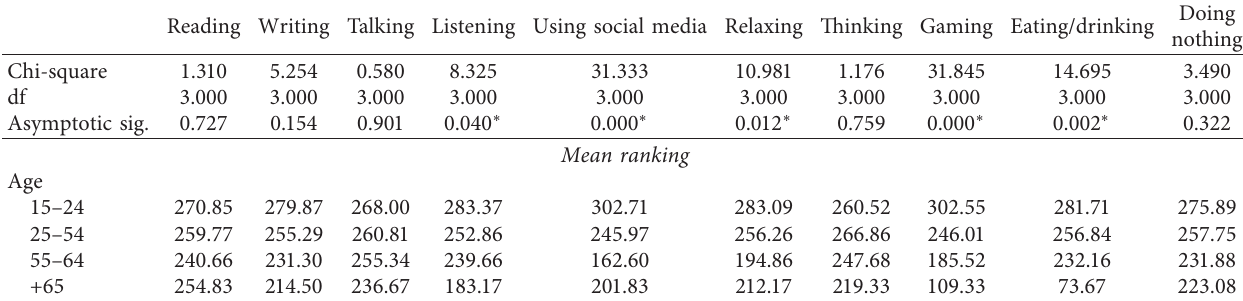
Table 19: Kruskal–Wallis test statistics and the rankings of age groups.